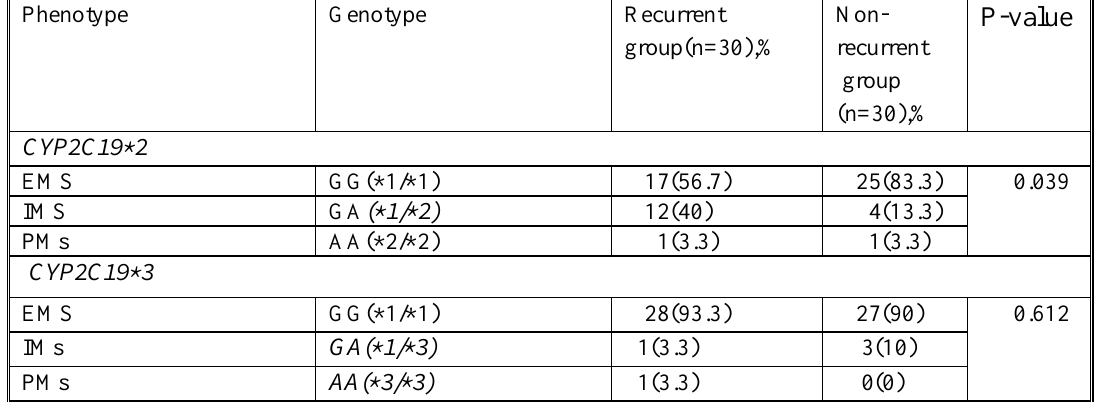
Table4.CYP2C19*2 and *3 genotype and phenotype association with recurrent ischemicstroke